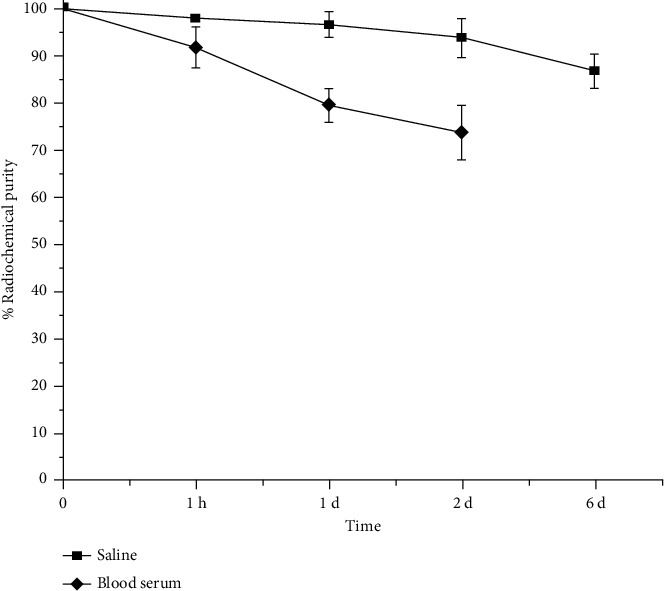

In vitro stability of 177Lu-acridine in saline and human blood serum.